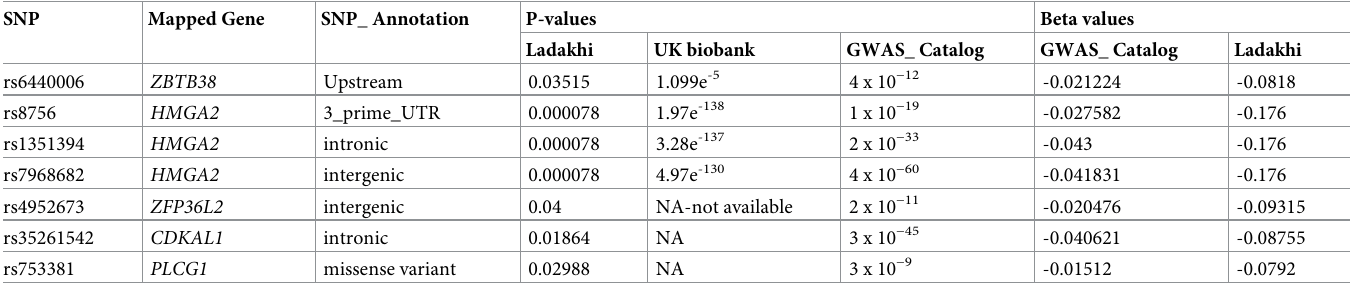
Single Nucleotide Polymorphism rs (rs) number and gene location along with P and Beta